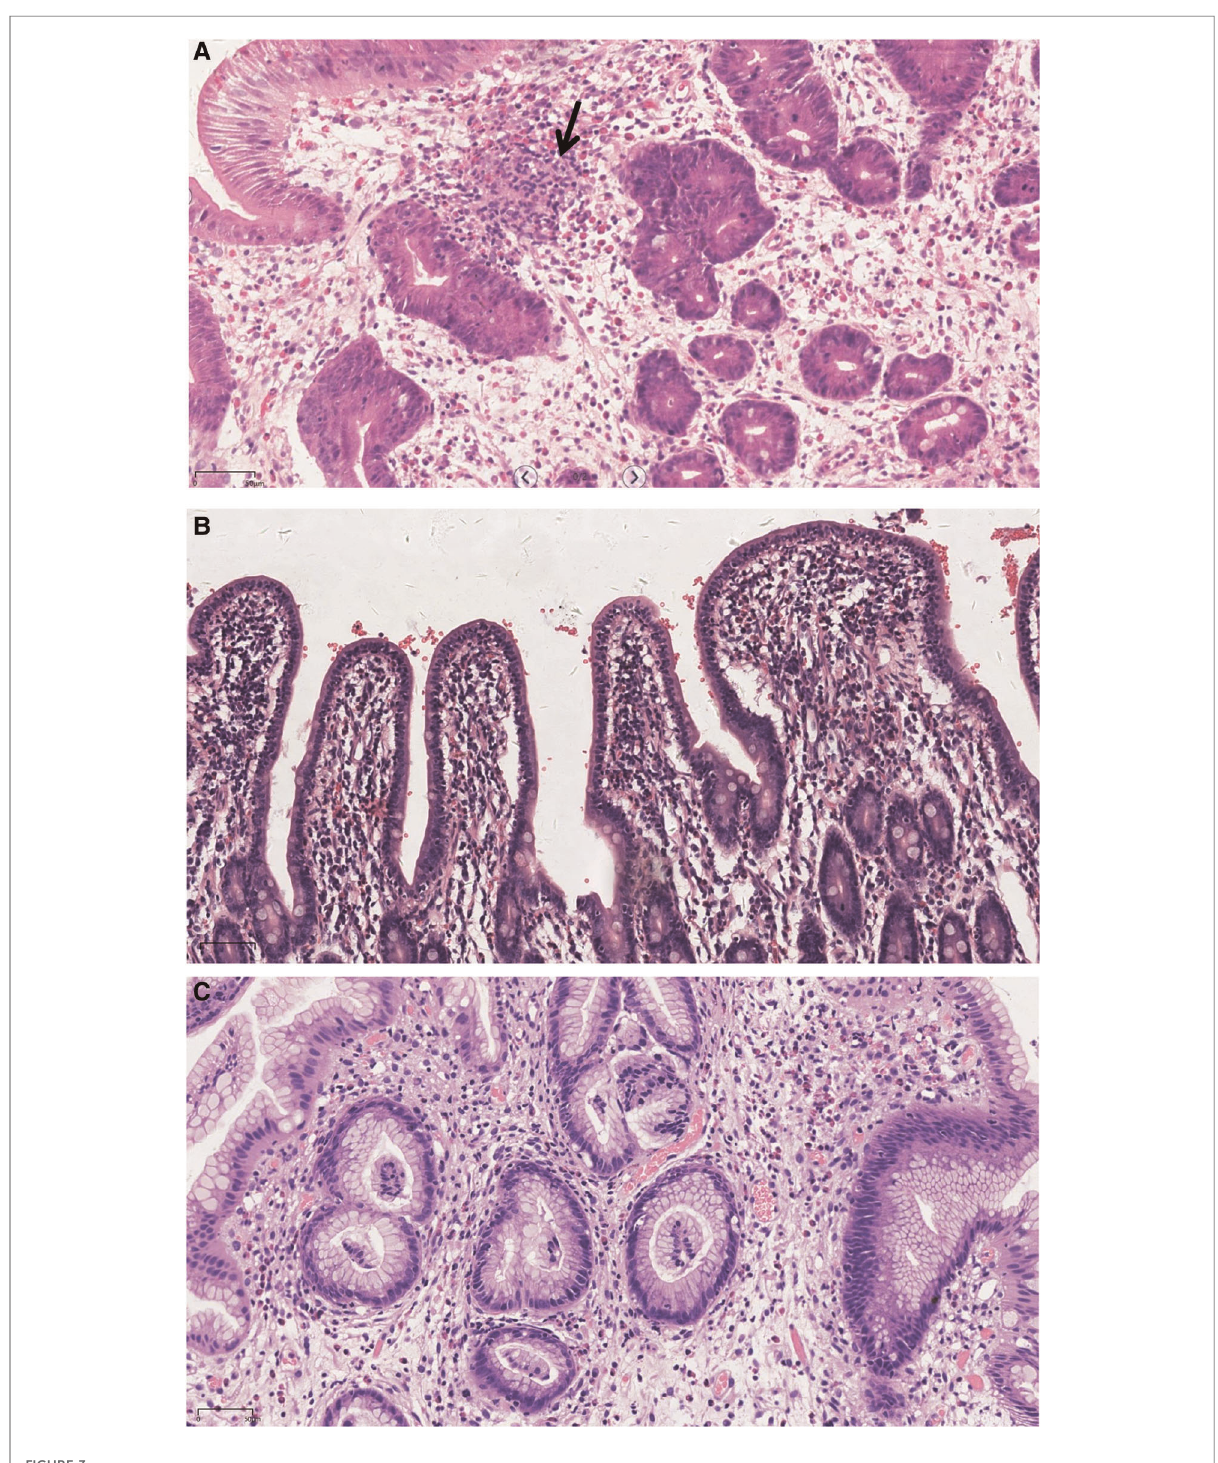
FIGURE 3 Representative histological images showing the in fi ltration of eosinophils, plasmocytes, and neutrophils in the upper gastrointestinal tract. ( A ) Gastric nonnecrotizing granulomas (arrow). ( B ) Small intestinal villi. ( C ) Gastric antrum (H&E, ×200; scale: 50